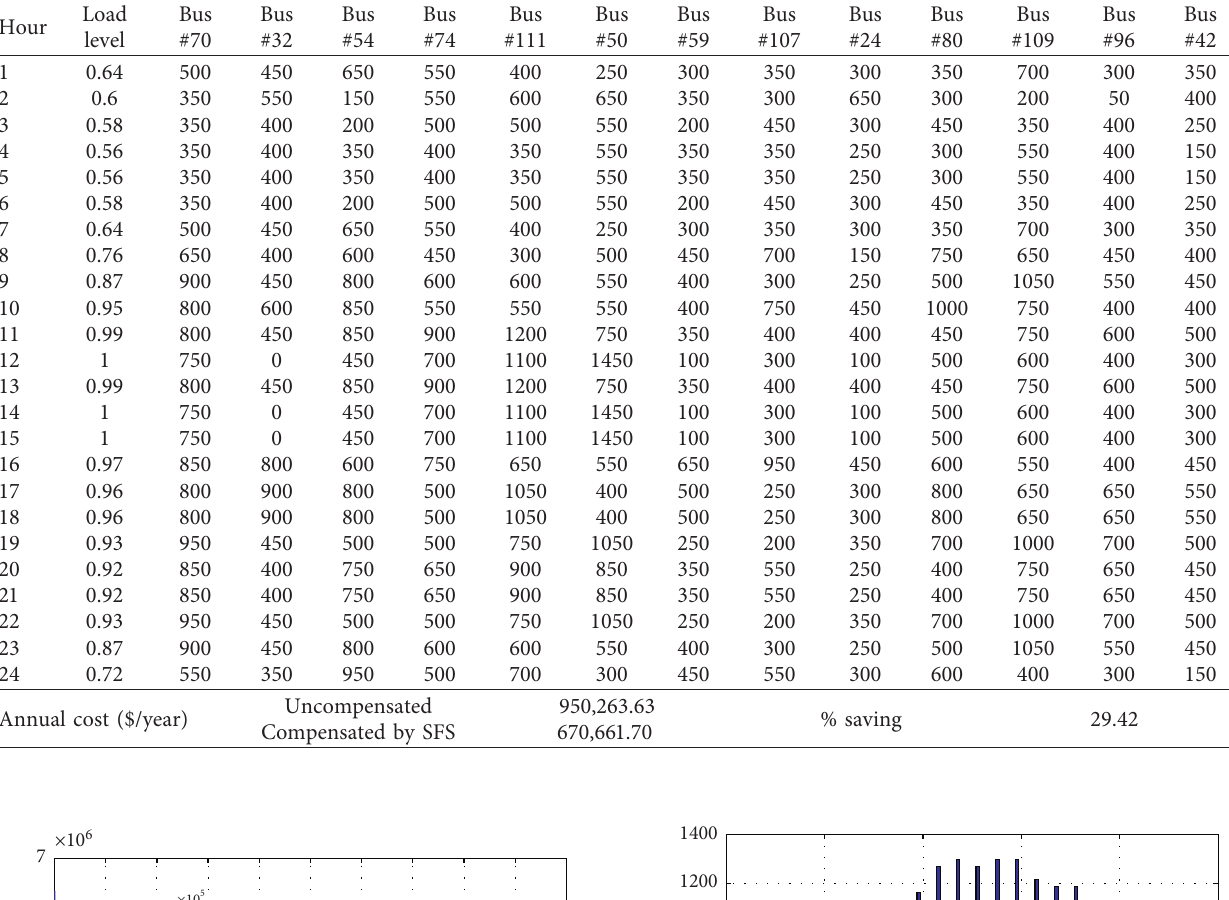
Table 10: On/off scheduling of switched SCs by ISFS for 119-bus network in scenario 2.